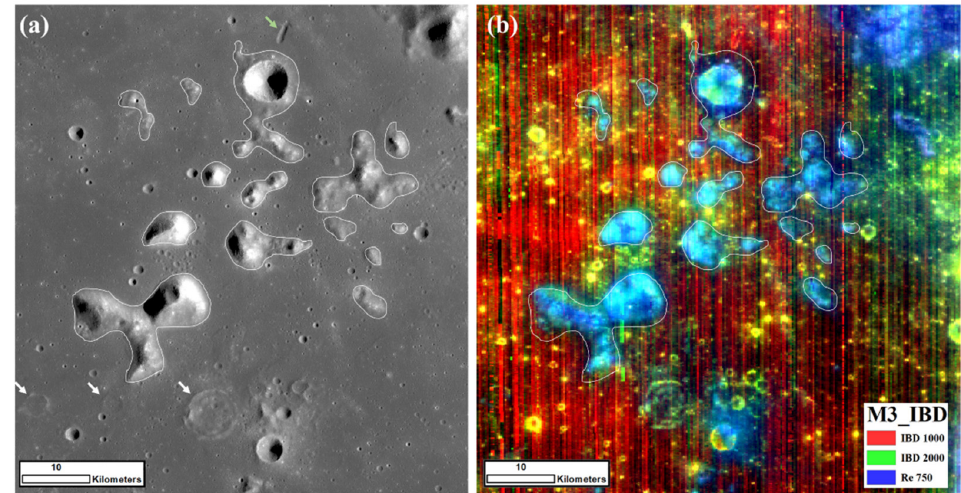
Figure 7. ( a ) The clustered kipukas (white polygons) in the eastern maria of the Crisium basin. The white arrows point out three pre-mare craters. A volcanic vent with a length of 3.5 km is marked (green arrow). ( b ) The RGB map of clustered kipukas in Figure 7a suggests potential highland